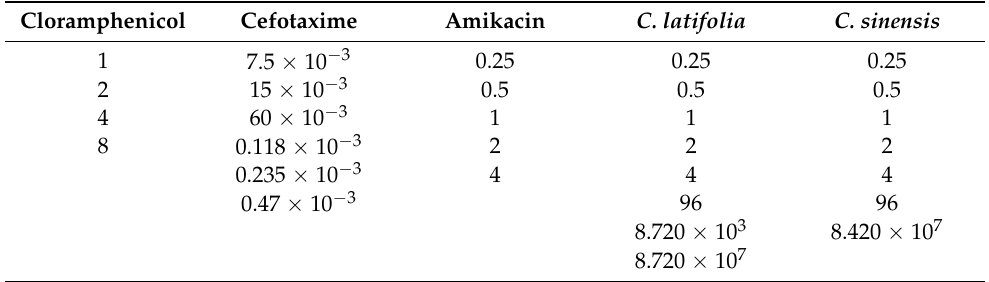
Table 3. Antibacterial concentrations ( µ g/mL) used for evaluation of E. coli strain.